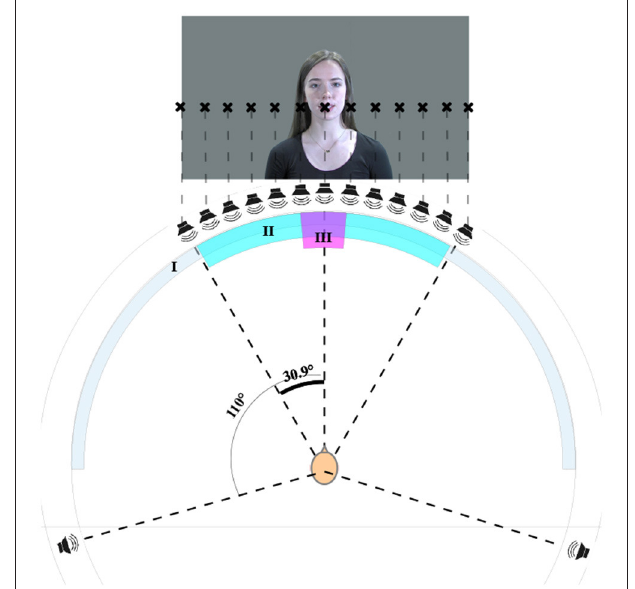
FIGURE 4 | Test setup showing the screen (I), the area covered by the loudspeakers and the video projection (II), and the area covered by the face (III). Written informed consent for publication of the personal image was obtained (CC BY-NC